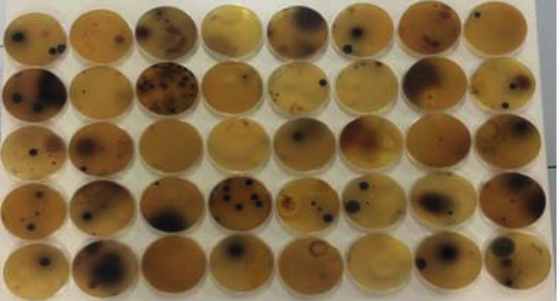
Figure 3 - Negative detection of afl atoxigenic fungi in CAV air in AFPA medium (absence of orange color on reverse of fungal colonies).